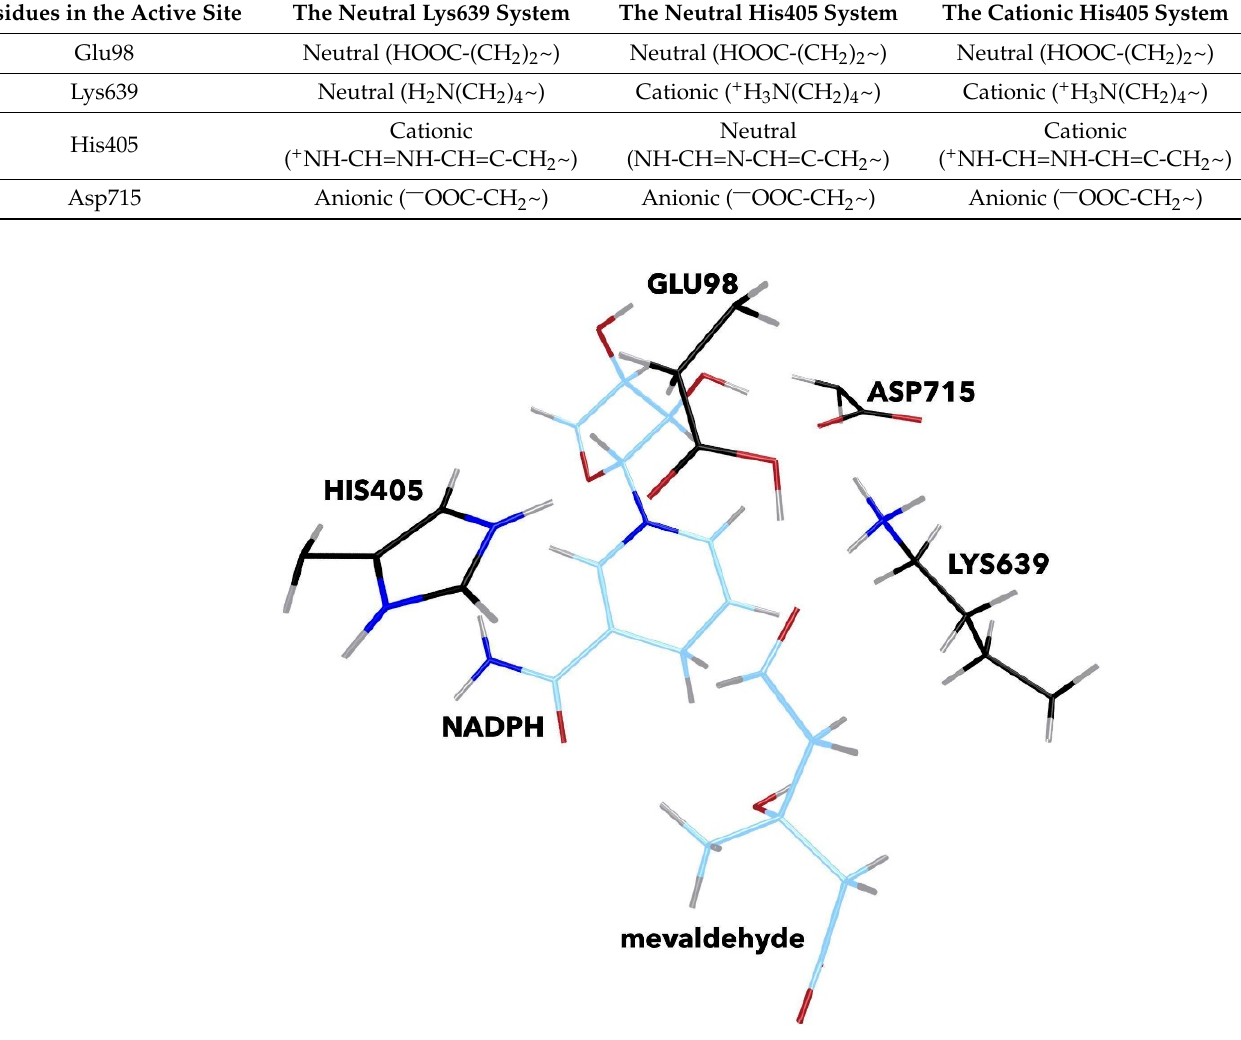
Figure 2. Representation of the active site for the most favorable system tested The Cationic His405 System : mevaldehyde intermediate and NADPH cofactor in blue and catalytic residues (Glu98, Asp715, His405, and Lys639) in black.